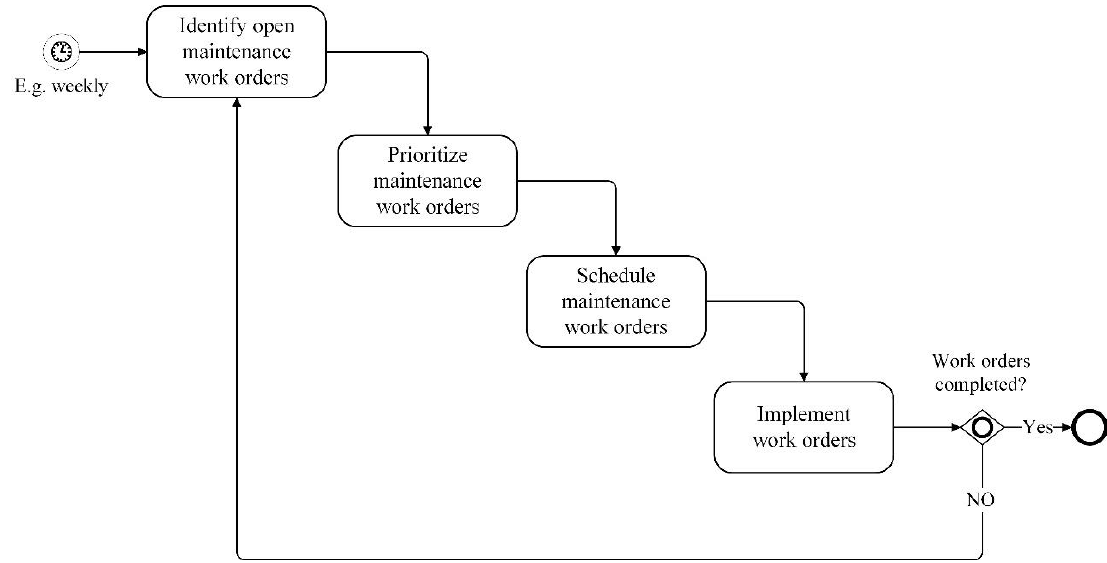
Figure 1. Simplified process for executing maintenance work orders.